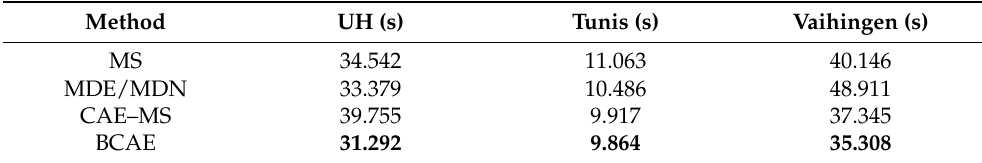
Table 12. The computational time of the proposed and competing methods for the three